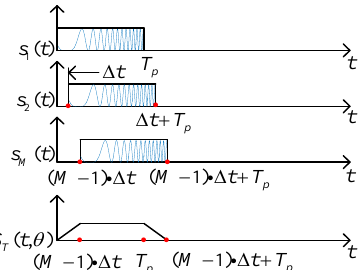
Figure 1. Sketch of circulating space-time coding LFM signal.